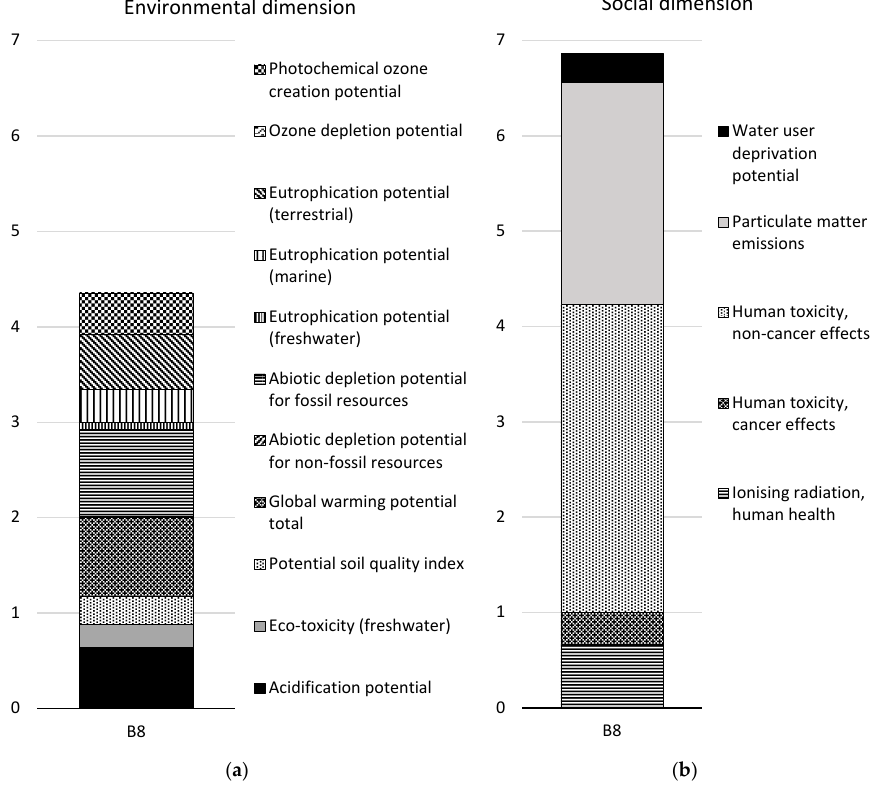
Figure 4. Normalized and weighted results for module B8 for both bridge design concepts in ( a ) the environmental dimension and ( b ) the social dimension for each indicator and for the functional unit. Note that the ozone depletion potential indicator bar cannot be seen in the figure since it is very